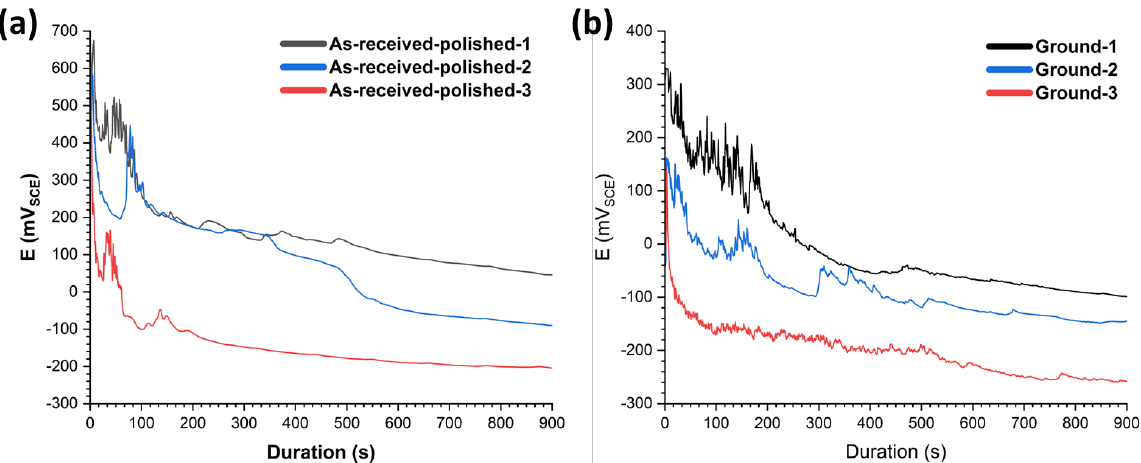
Figure 5. Galvanostatic polarization results in specimens with various energy input densities, for ( a ) as-received polished and ( b ) ground state.